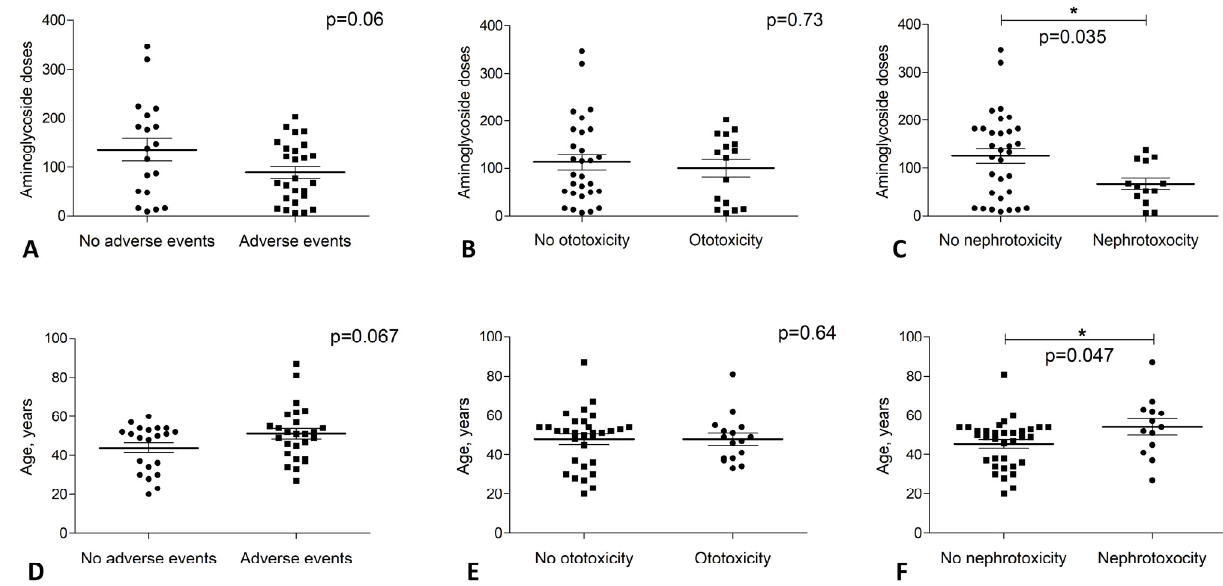
Figure 1. Occurrence of adverse events—ototoxicity and nephrotoxicity—in patients with MDR-TB depending on the age and the number of injections received. ( A – C )—adverse event occurrence depending on injections received. ( D – F )—adverse event occurrence depending on the patient’s age. Mann–Whitney non-parametric test, values of p ≤ 0.05 were considered significant. *— p <